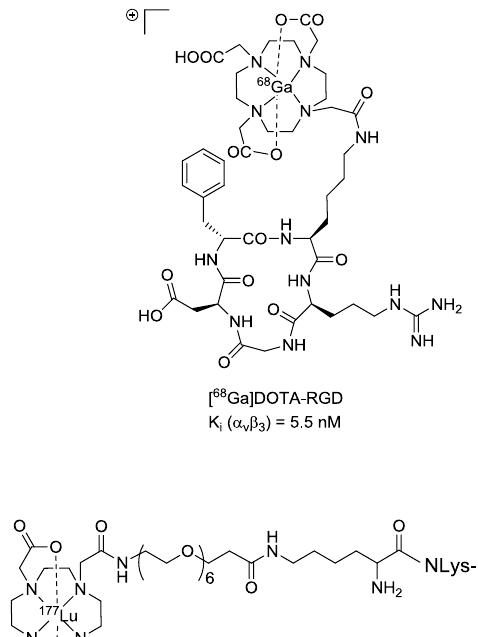
Figure 1. Chemical structures of [ 68 Ga]DOTA-RGD [35] ( top ) and [ 177 Lu] NT127 ( bottom